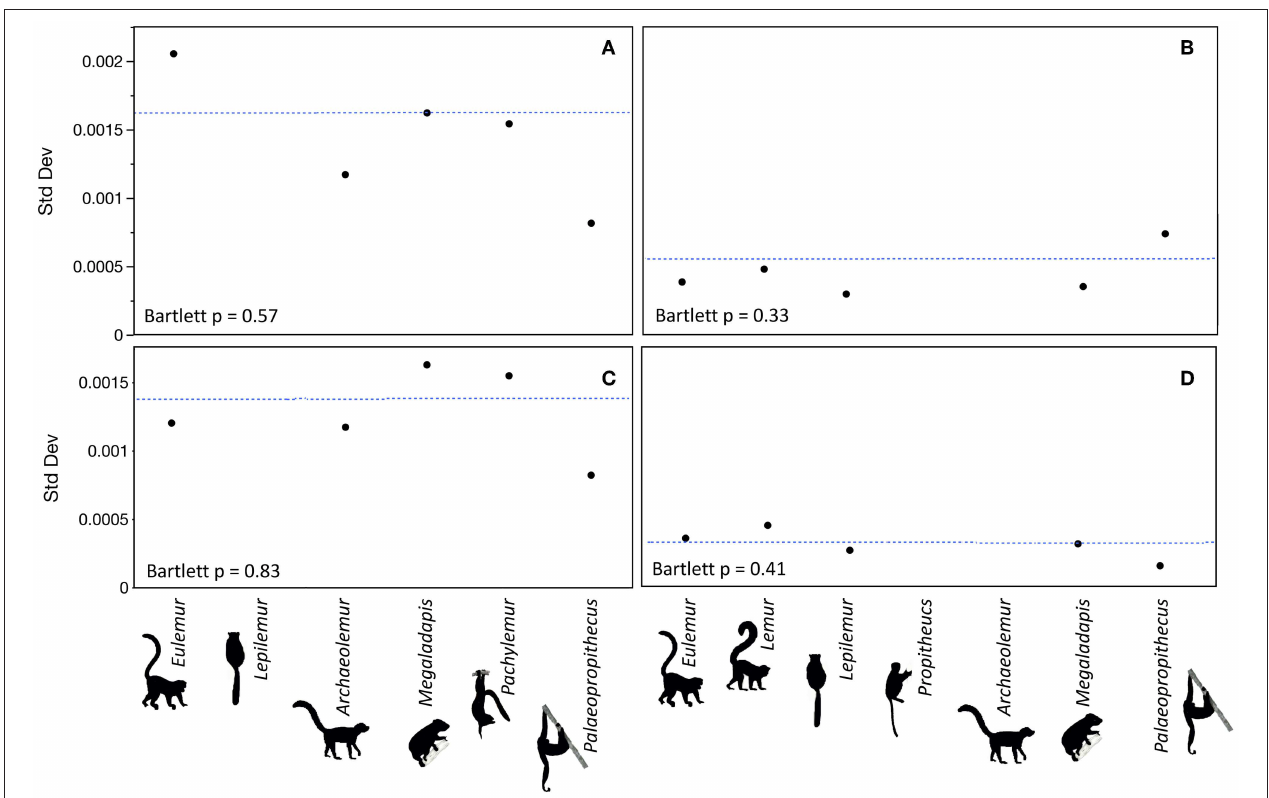
FIGURE 4 | Standard deviations of 87 Sr/ 86 Sr for each genus at Ampasambazimba (A) and (C) and Ankilitelo/Mikoboka (B) and (D) . The dashed blue lines in each panel indicate the average for all taxa. Outliers are included in (A) and (C) and excluded in (B) and (D)